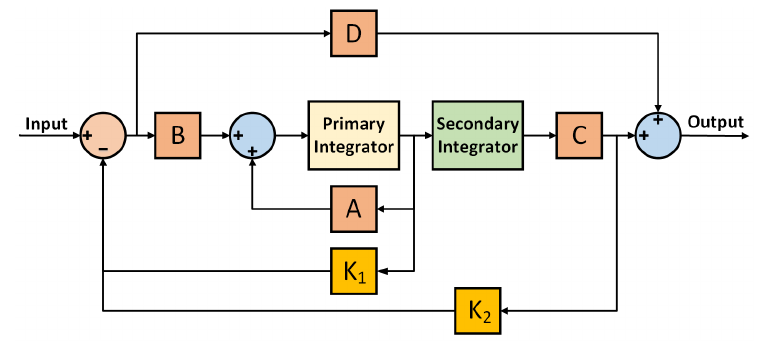
Figure 8. Schematic diagram of HLQR and its integration into